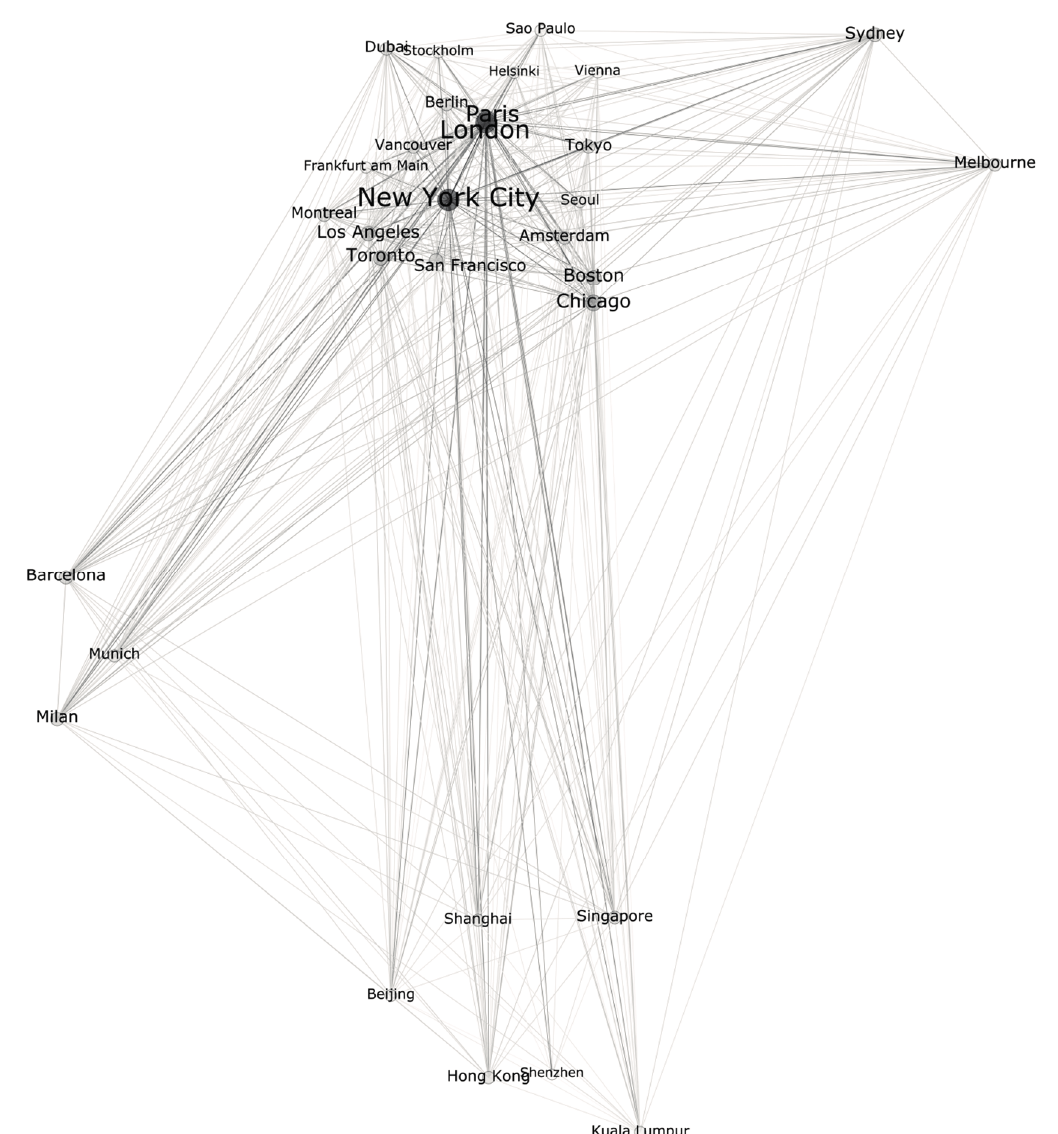
Figure 7. The closeness between cities according user